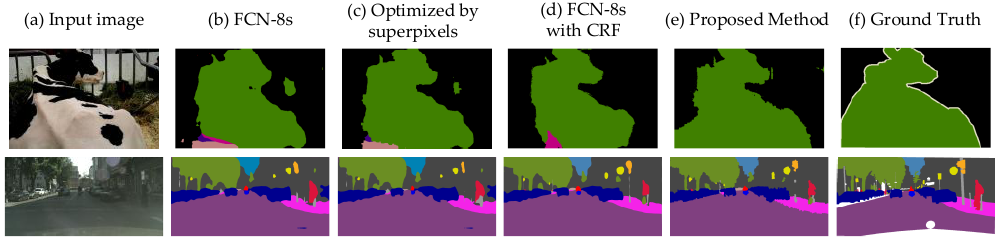
Figure 9. An example result of the comparative experiments. ( a ) The input image, ( b ) the result of plain FCN-8s, ( c ) the boundary optimization result by superpixels, ( d ) the result of FCN-8s with CRF post-processing, ( e ) the result of our method, and ( f ) the ground truth.